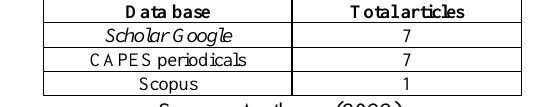
Table 2: Number of articles obtained from the research